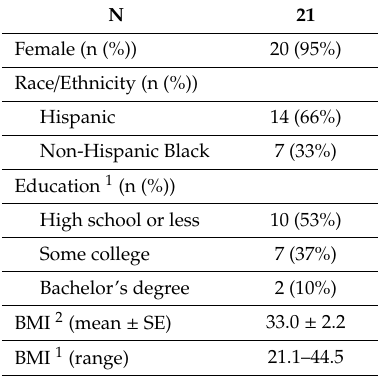
Table 1. Characteristics of the Study Participants ( n =